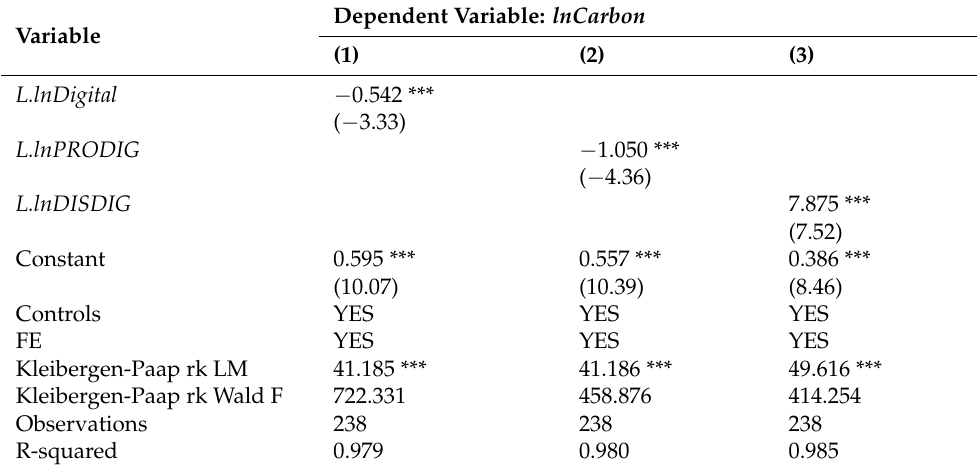
Table 7. Regression results of endogenous